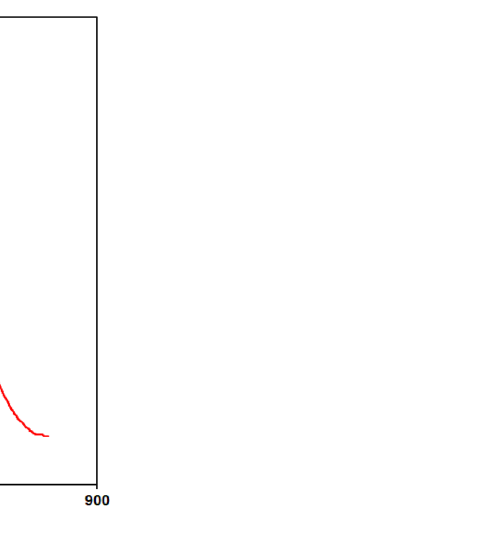
Figure 5. TGA under air of the Fe 3 O 4 @ZIF-8